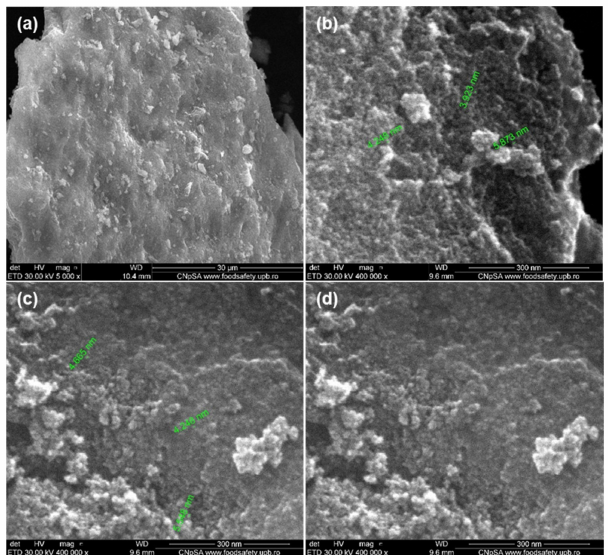
Figure 15. SEM micrographs of Fe 3 O 4 @ β -CD nanopowders at ( a ) low-magnification (5000 × ) and ( b – d ) high-magnification (400,000 ×